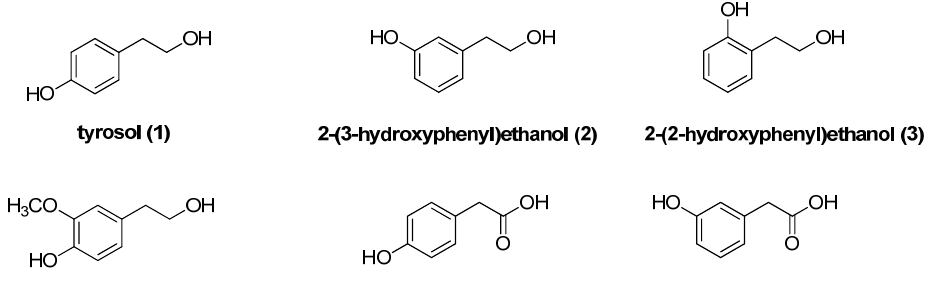
Figure 1. The chemical structures of tyrosol